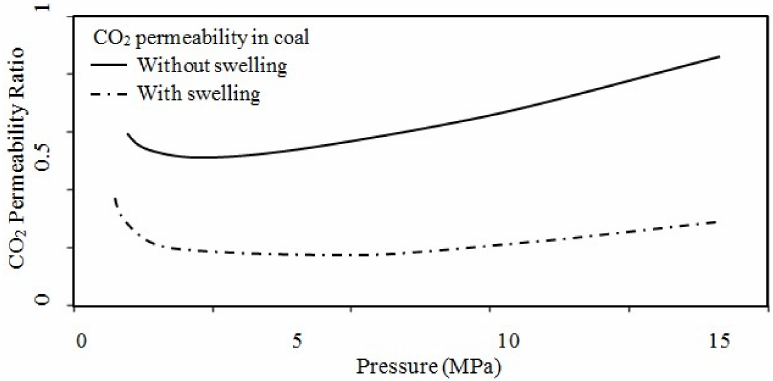
Figure 3. Change of CO 2 permeability in coal with swelling process and the pressure effect on it